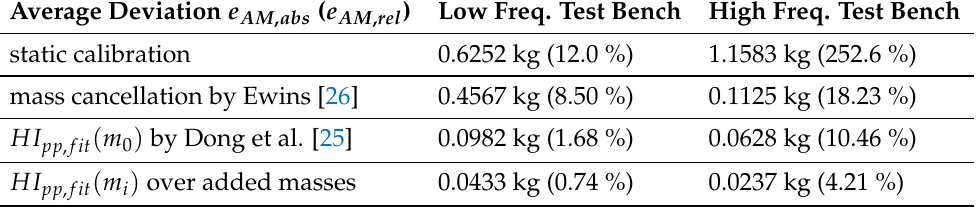
Table 2. Comparison of average deviation e AM by Equation (22) for static calibration, mass cancella- tion by Ewins [26] , HI pp , fit ( m 0 ) by Dong et al. [25], HI pp , fit ( m i ) over different added masses. Average Deviation e AM , abs ( e AM , rel